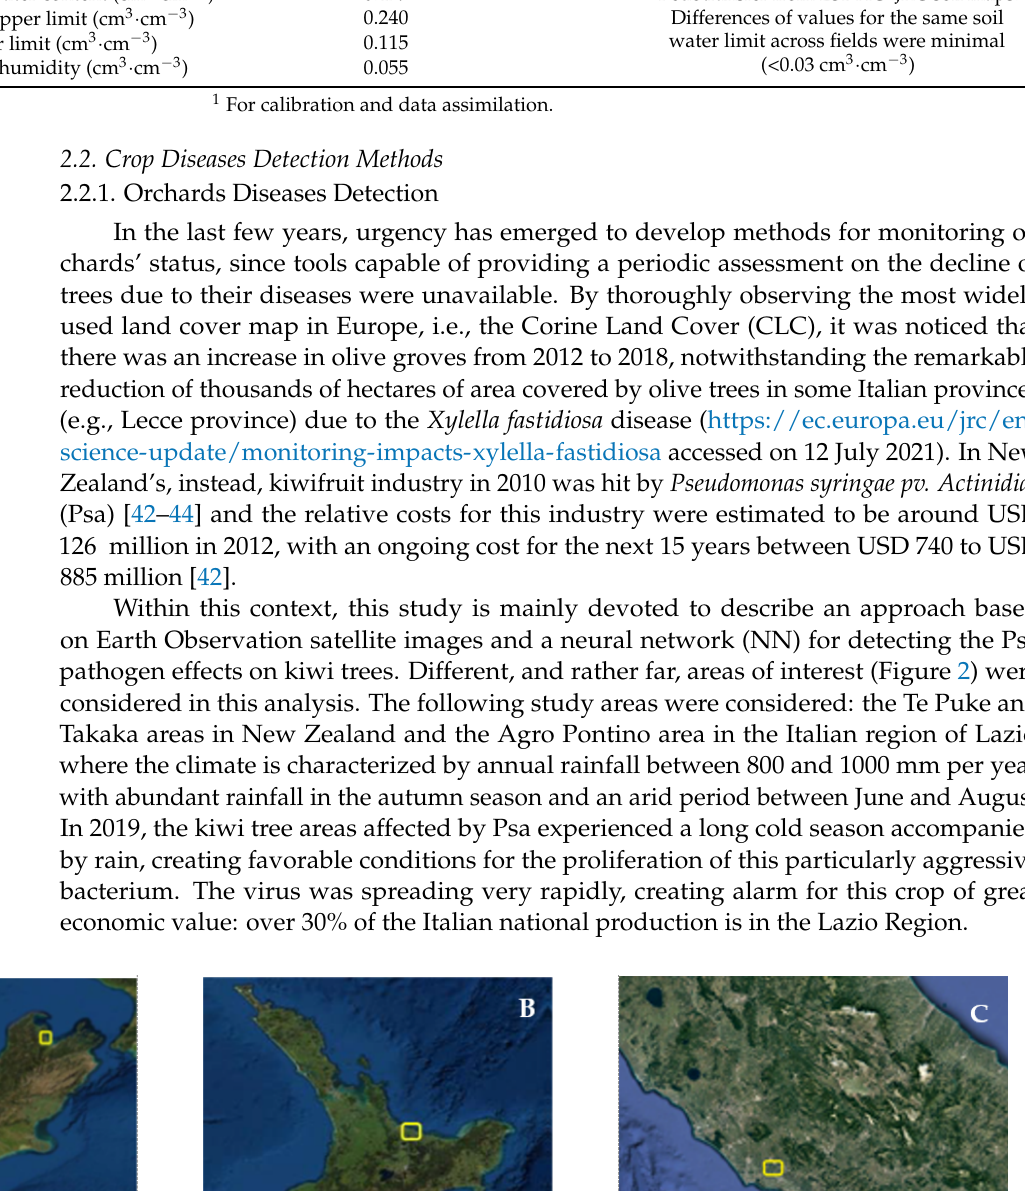
m of spatial resolution. The following vegetation indices (VI) were applied to the RapidEye data set: Simple ratio (SR), the Normalized difference vegetative index (NDVI), Green NDVI (G-NDVI), Red-edge NDVI (ReNDVI), Modified red-edge NDVI (MRe-NDVI), Enhanced vegetative index (EVI), Enhanced vegetative index 2 (EVI2), Photosynthetic vigor ratio (PVR), Green chlorophyll index (GCI), Red-edge chlorophyll index (ReCI), Triangular vegetative index (TVI), and the MERIS terrestrial chlorophyll index (MTCI). Additional indexes were applied to Sentinel-2 images, taking advantage of the 13 spectral channels in the VSWIR spectral range. The new set of vegetation indices includes: Leaf Chlorophyll Index (LCI), Tasseled Cap-Green Vegetation Index (TCGVI), Green at- mospherically resistant vegetation index (GARVI), Structure Intensive Pigment Index 1 (SIPI1), Structure Intensive Pigment Index 2 (SIPI2), Modified Chlorophyll Absorption in Reflectance Index (modCARI), Atmospheric Resistant Vegetation Index (ARVI), and the Optimized Soil Adjusted Vegetation Index (OSAVI). Finally, the use of PRISMA hyperspectral satellite data (having 30 m spatial resolu- tion) allowed the definition of a larger set of indices peculiar to an hyperspectral imagery: NDRE, modNDRE, PSSR-1, PSSR-2, PSND-1, PSND-2, PSRI, CARI, CRI-1, CRI-2, NDLI, MDNI, RVSI, NDVI-750, mNDVI-750, VOG-1, VOG-2, GM-1, GM-2, LIC-1, and MTVI-2. The list and details of all indices can be found at https://www.indexdata- base.de/db/i.php?offset=1 (accessed on 15 May 2020). Moreover, for this study, 400 fields were digitized through visual interpretation (Fig- ure 3A) from the Te Puke area, setting randomly selected sub-samples of 60% of the fields for training, 20% for validation, and 20% for testing the network. The Levenberg-Mar- quardt back-propagation function was used for the training process, and the error estima- tion was computed by minimum squares.